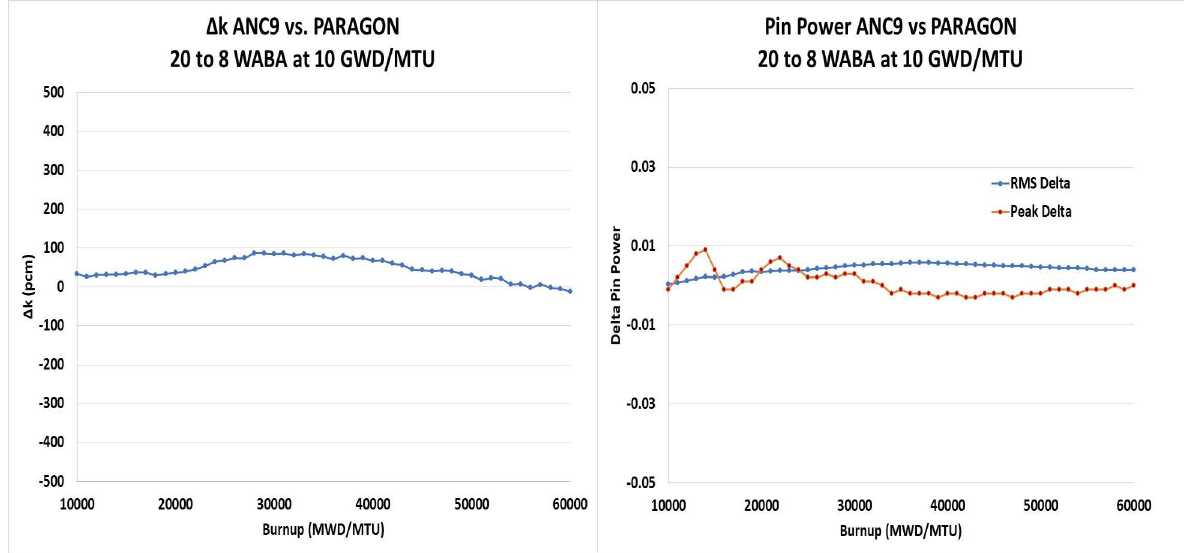
Figure 6. Comparison of eigenvalue and pin power for WABA replacement from 20 to 8 rods at 10